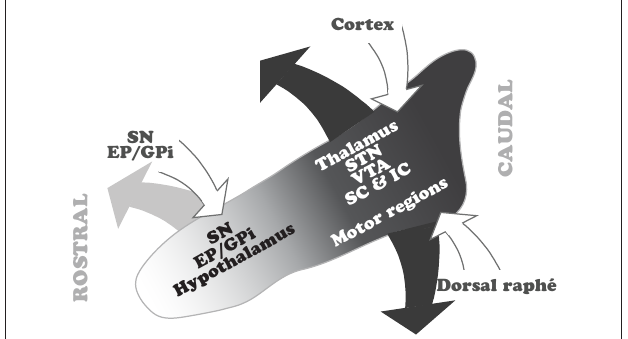
Figure 2 | Summary of the topographical distribution of the connectivity in the PPN. The rostral PPN, which is predominantly GABAergic, maintains interconnections with the GABAergic output of the basal ganglia. In contrast, the caudal PPN, where cholinergic and glutamatergic neurons are more abundant, receives input from the cortex and dorsal raphé and projects to the thalamocortical systems, STN and locomotor regions. Only major inputs and outputs, and those structures whose connectivity with the PPN is topographically organized, are depicted in this scheme. EP, entopeduncular nucleus; GPi, internal segment of the globus pallidus; IC, inferior colliculus; SC, superior colliculus; SN, substantia nigra; STN, subthalamic nucleus; VTA, ventral